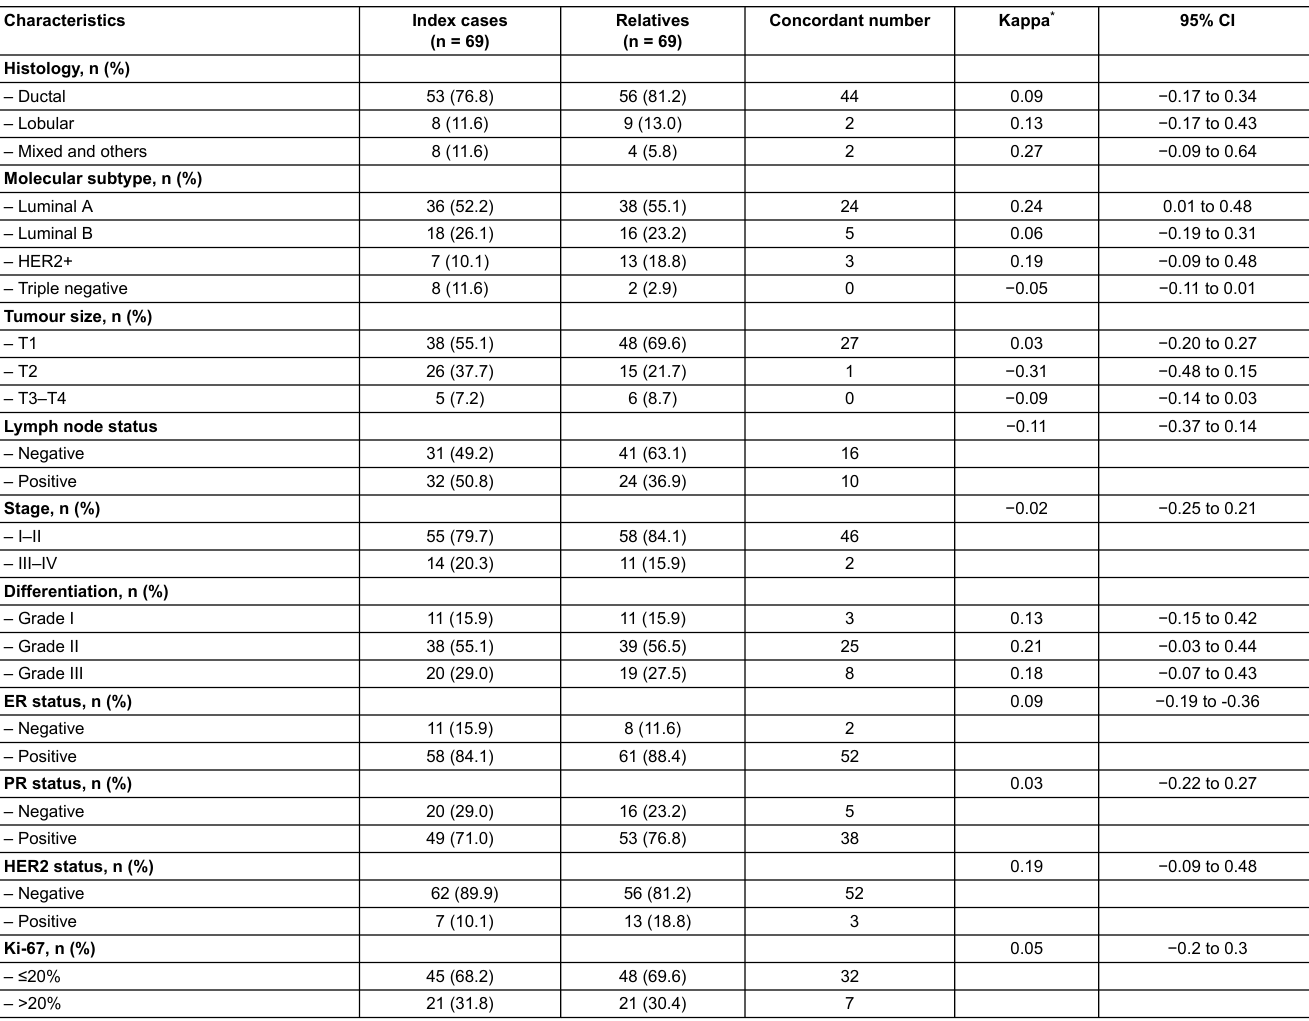
Table 2: Tumour characteristics of breast cancer in mother-daughter pairs (data from pathology review).